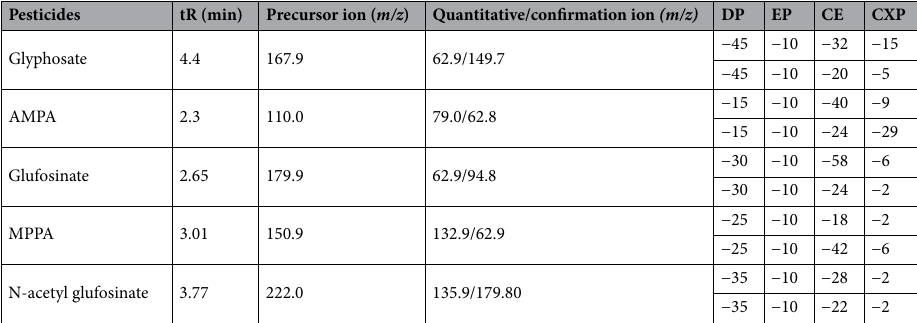
Table 2. Multiple reaction monitoring (MRM) conditions of each target compound for LC–MS/MS analysis. AMPA aminomethylphophonic acid; MPPA 3-methylphosphinico-propionic acid, DP declustering potential, EP entrance potential, CE collision energy, CXP collision cell exit